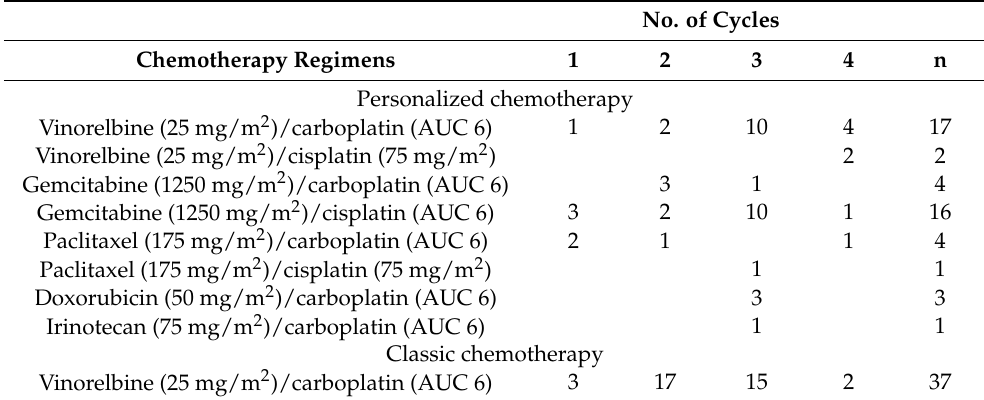
Table 4. Chemotherapy regimens for the studied groups of patients with non-small-cell lung cancer.